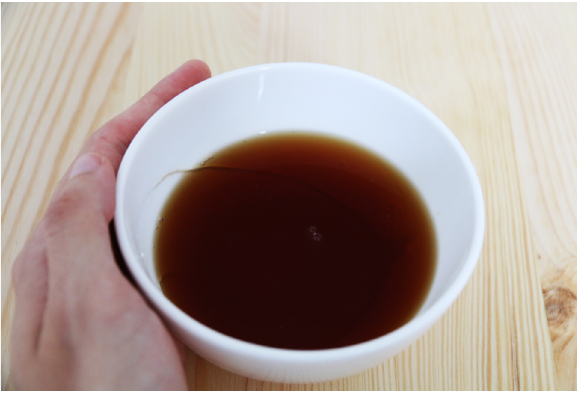
Figure 2 | Photo of “Chrysalis Gemini”.